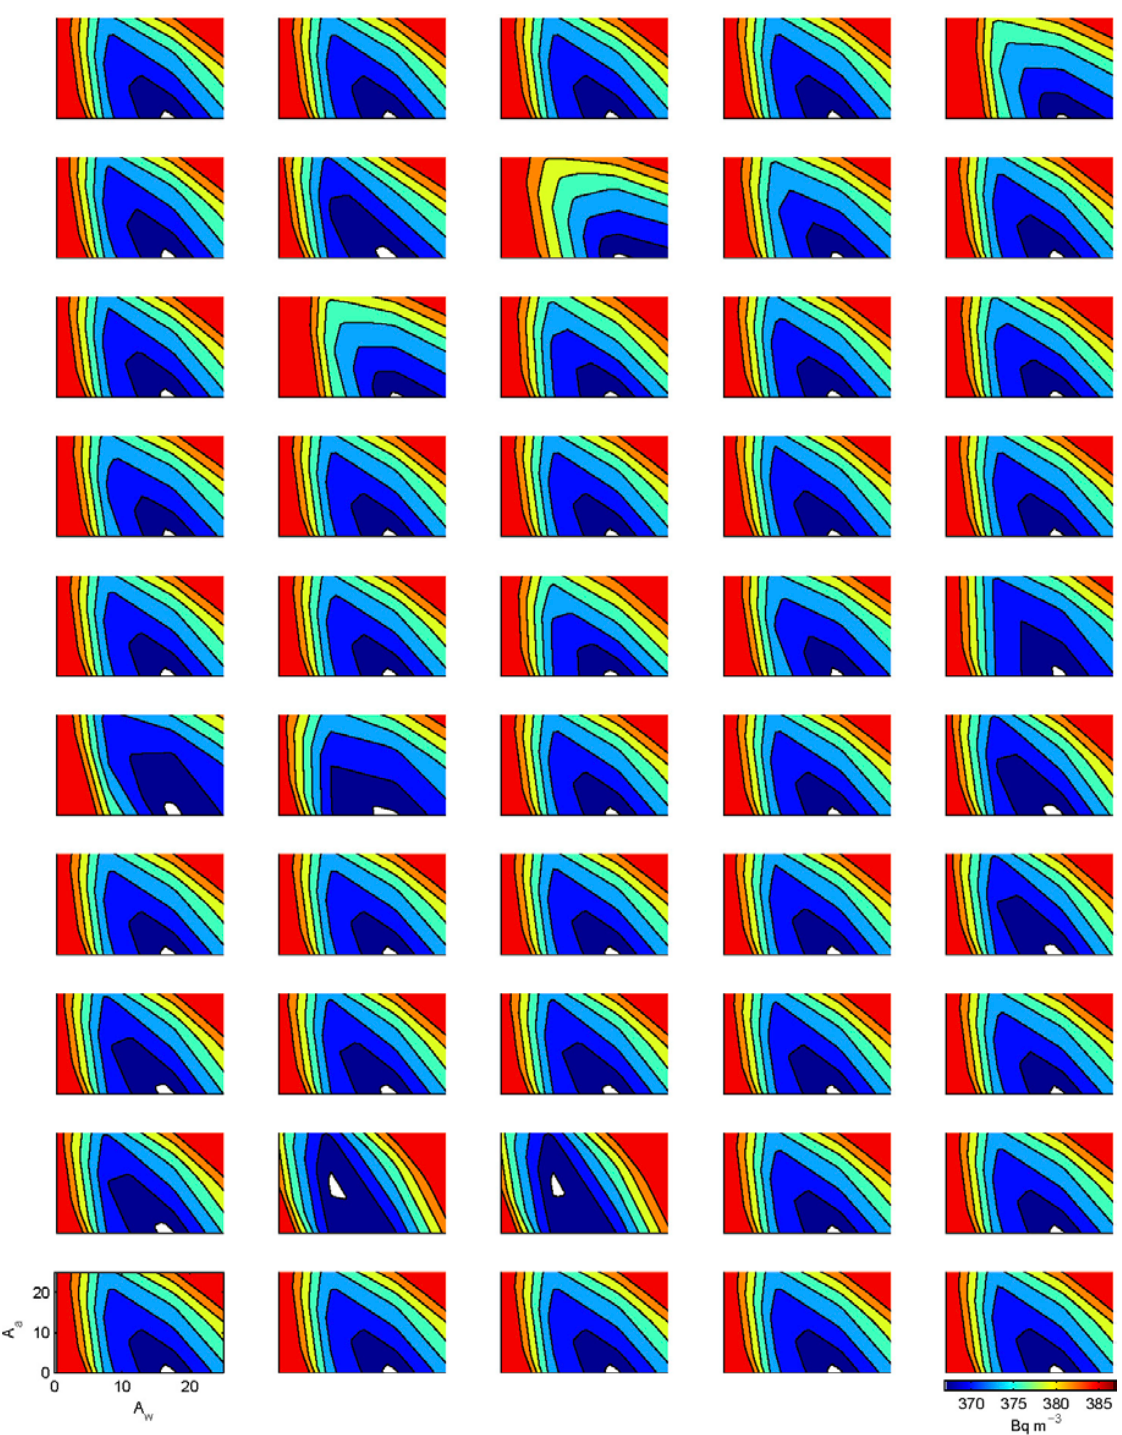
Fig. A1. Error function “Er” from Eq. (1) as a function of the oceanic and atmospheric source strengths, A atm and A ocean , for 50 cases resulting from the bootstrapping procedure of sequentially eliminating one station at a time. The position of the minimum is indicated as a small white region in each panel. Color bars are slightly different for different subplots. To put the mean error values in perspective, the mean measured Cs concentration averaged over all stations is 415Bqm − 3 .